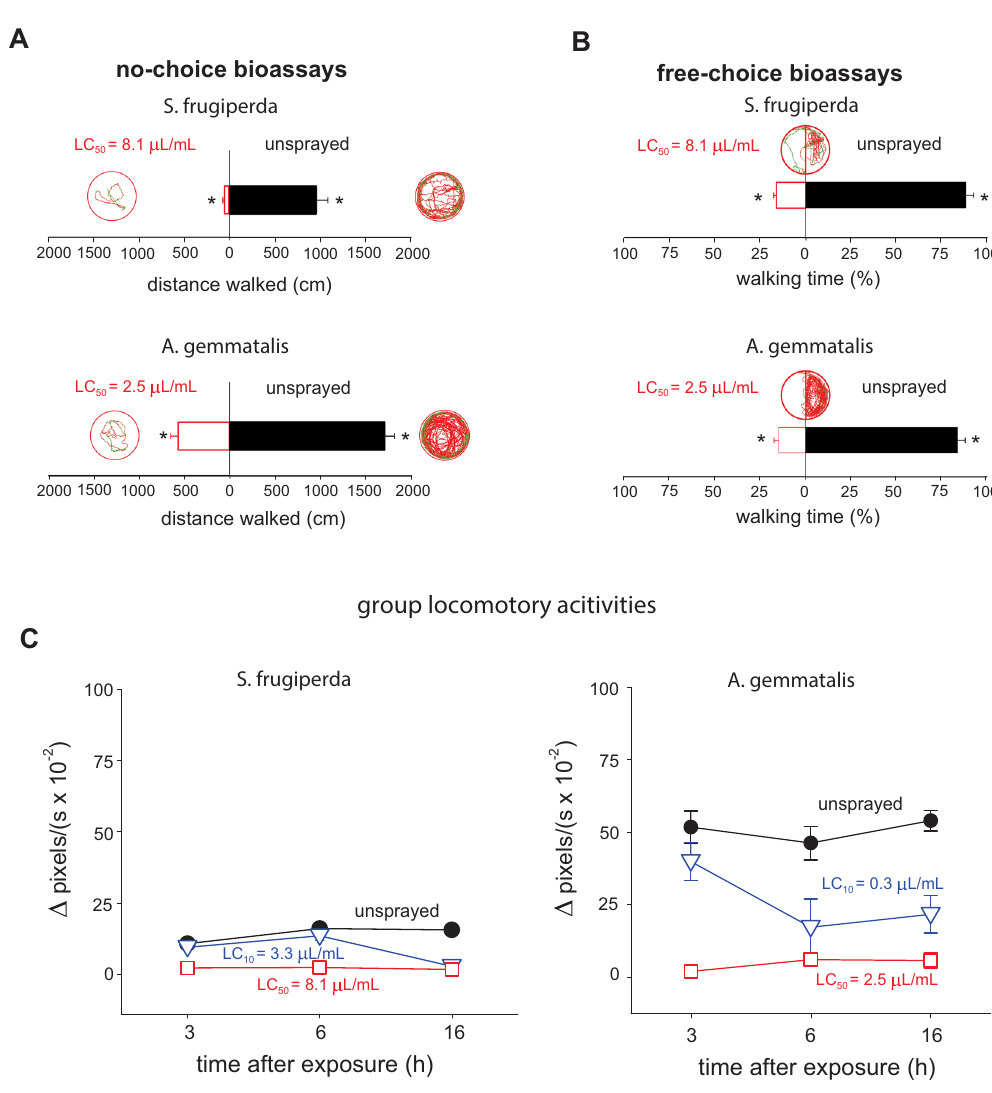
Figure 7. Individual walking behavior ( A , B ) and group activity ( C ) of 3 rd instar larvae of Spodoptera frugiperda and Anticarsia gemmatalis exposed to Siparuna guianensis essential oil in arenas fully treated and untreated ( A , C ) or half-treated ( B ). Asterisks indicate significant differences ( P < 0.05) between exposed and unexposed